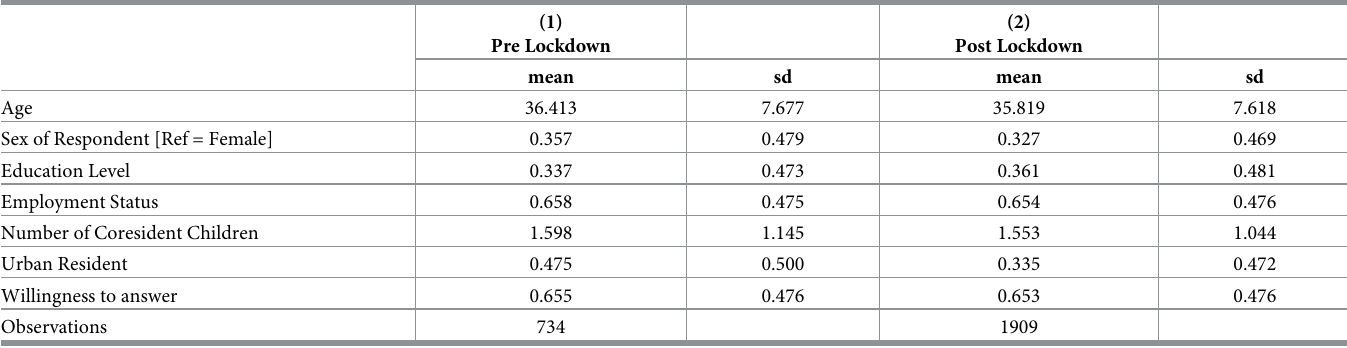
Table 2. Independent